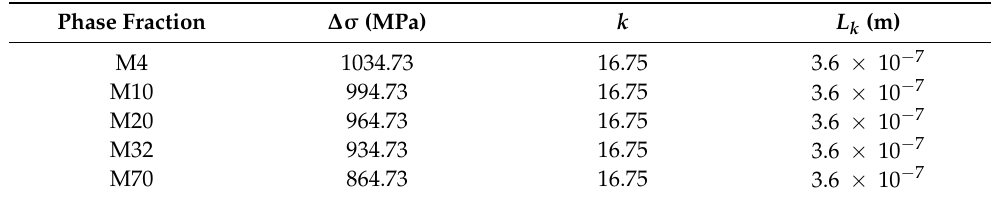
Table 6. Determined constants used for prediction the flow curves of the specimens with varying martensite volume fractions.